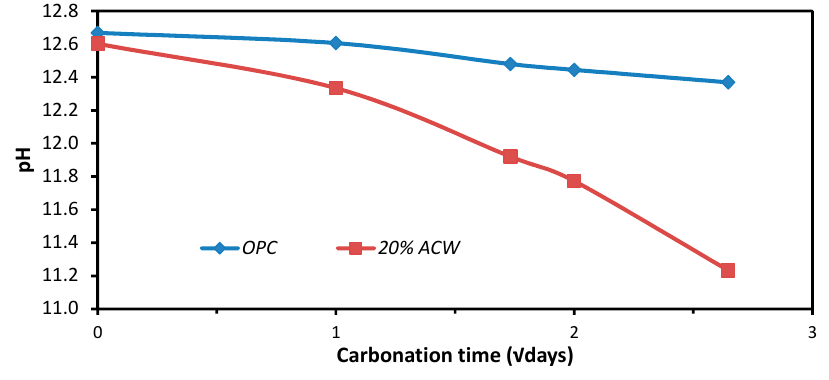
Figure 3. pH vs. square root of exposure time.